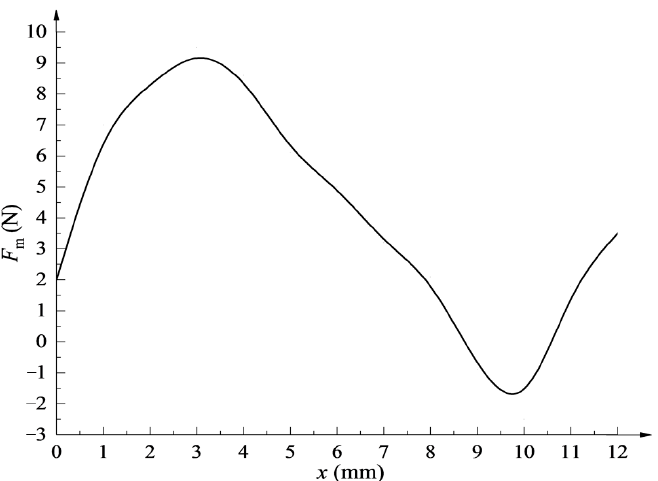
Figure 3. Relationship between valve core displacement and rubber diaphragm rebound force.